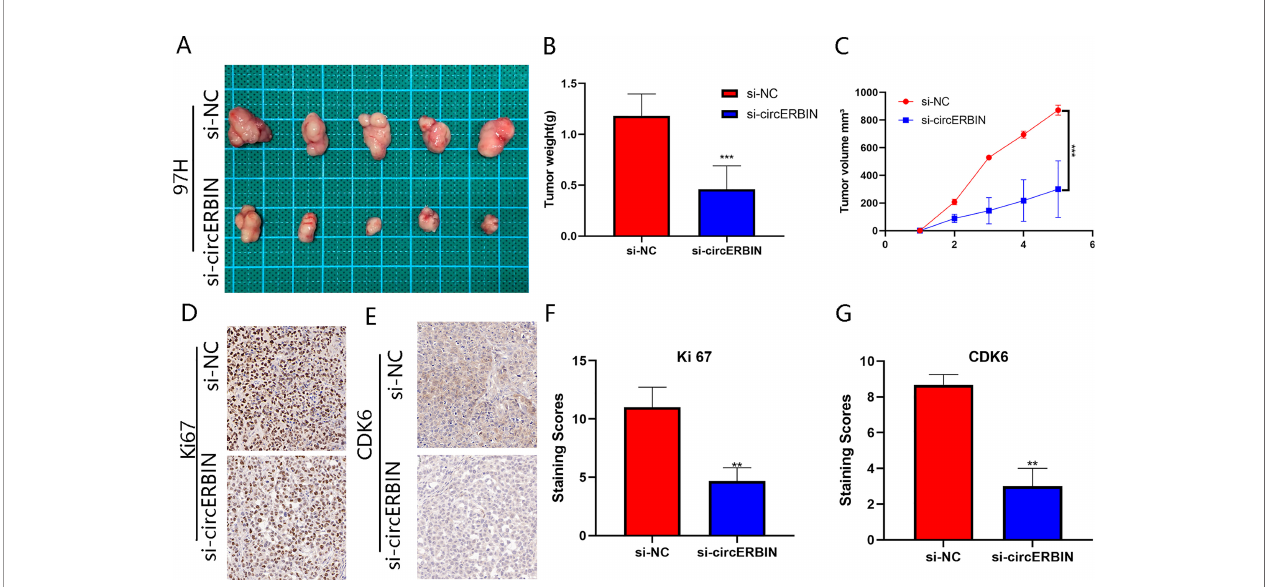
FIGURE 3 | CircERBIN promotes the proliferation of HCC cells in vivo. (A – C) 97H cells transfected with si-circ-ERBIN were injected into BALB/C nude mice (n = 5/group). Tumor volumes and weights were monitored. (D, F) IHC staining of xenograft tumors. The protein levels of Ki67 were analyzed based on IHC staining. (E, G) IHC staining of xenograft tumors. The protein levels of CDK6 were analyzed based on IHC staining. The samples were imaged at 400× magni fi cation. (** p < 0.01, *** p <